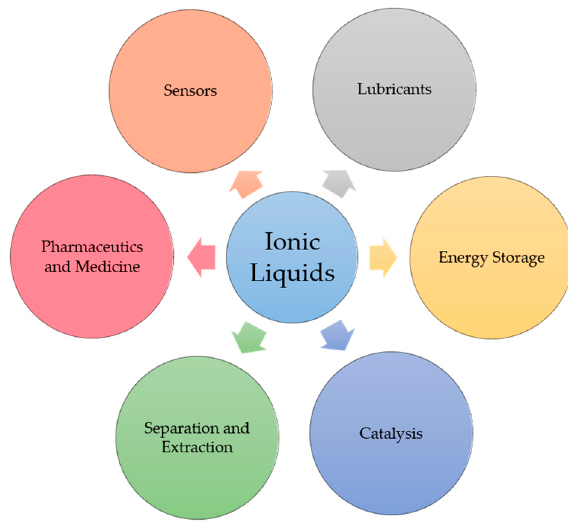
Figure 5. Common applications of ionic liquids.